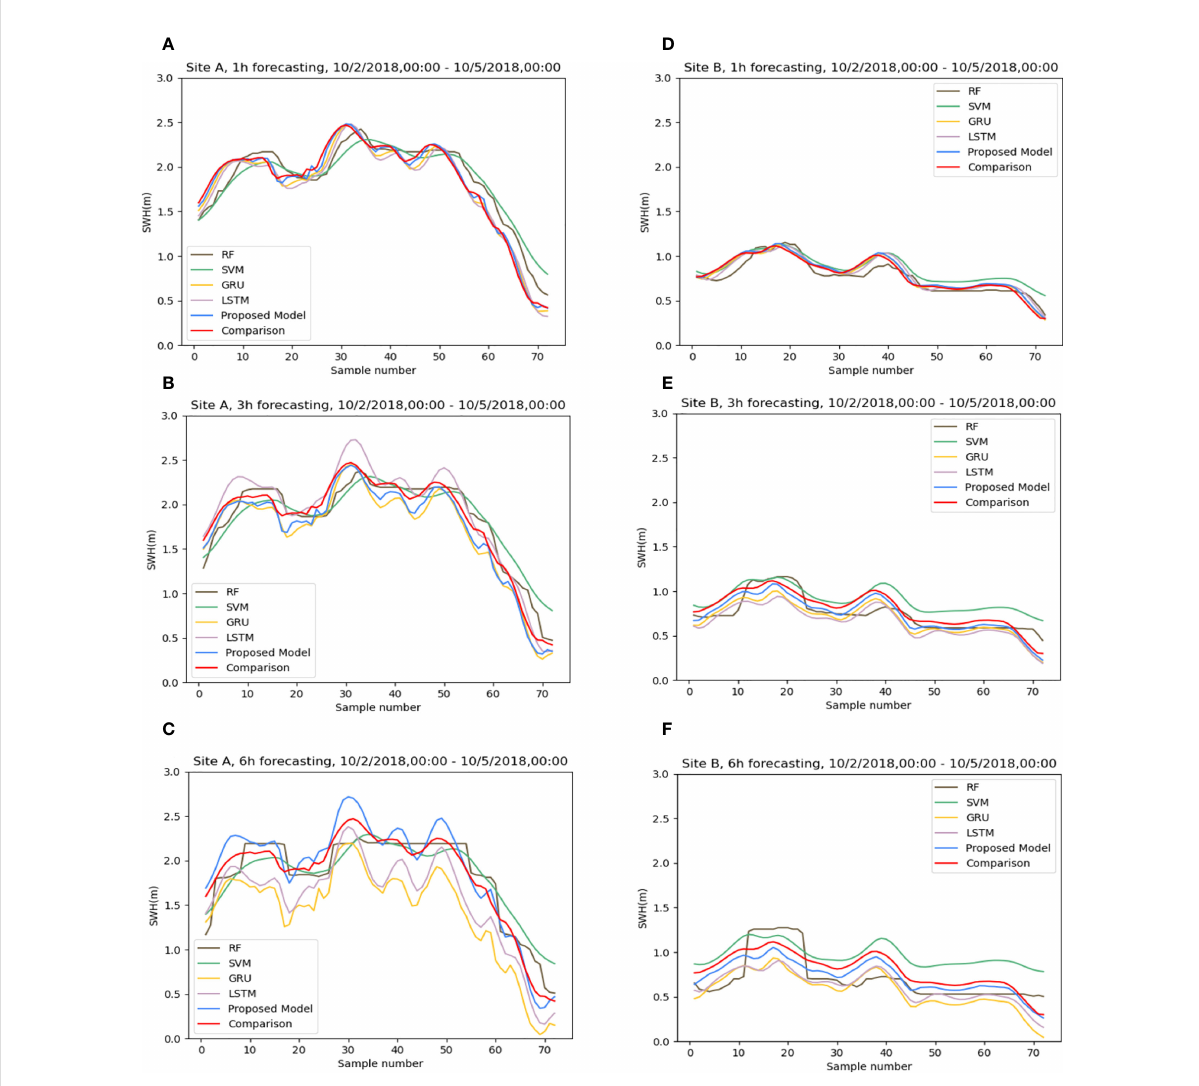
FIGURE 6 The differences in prediction effects of different algorithms at sites (A, B) : (A, D) 1h, (B, E) 3h, (C, F) 6h. Sample number indicates the time sample